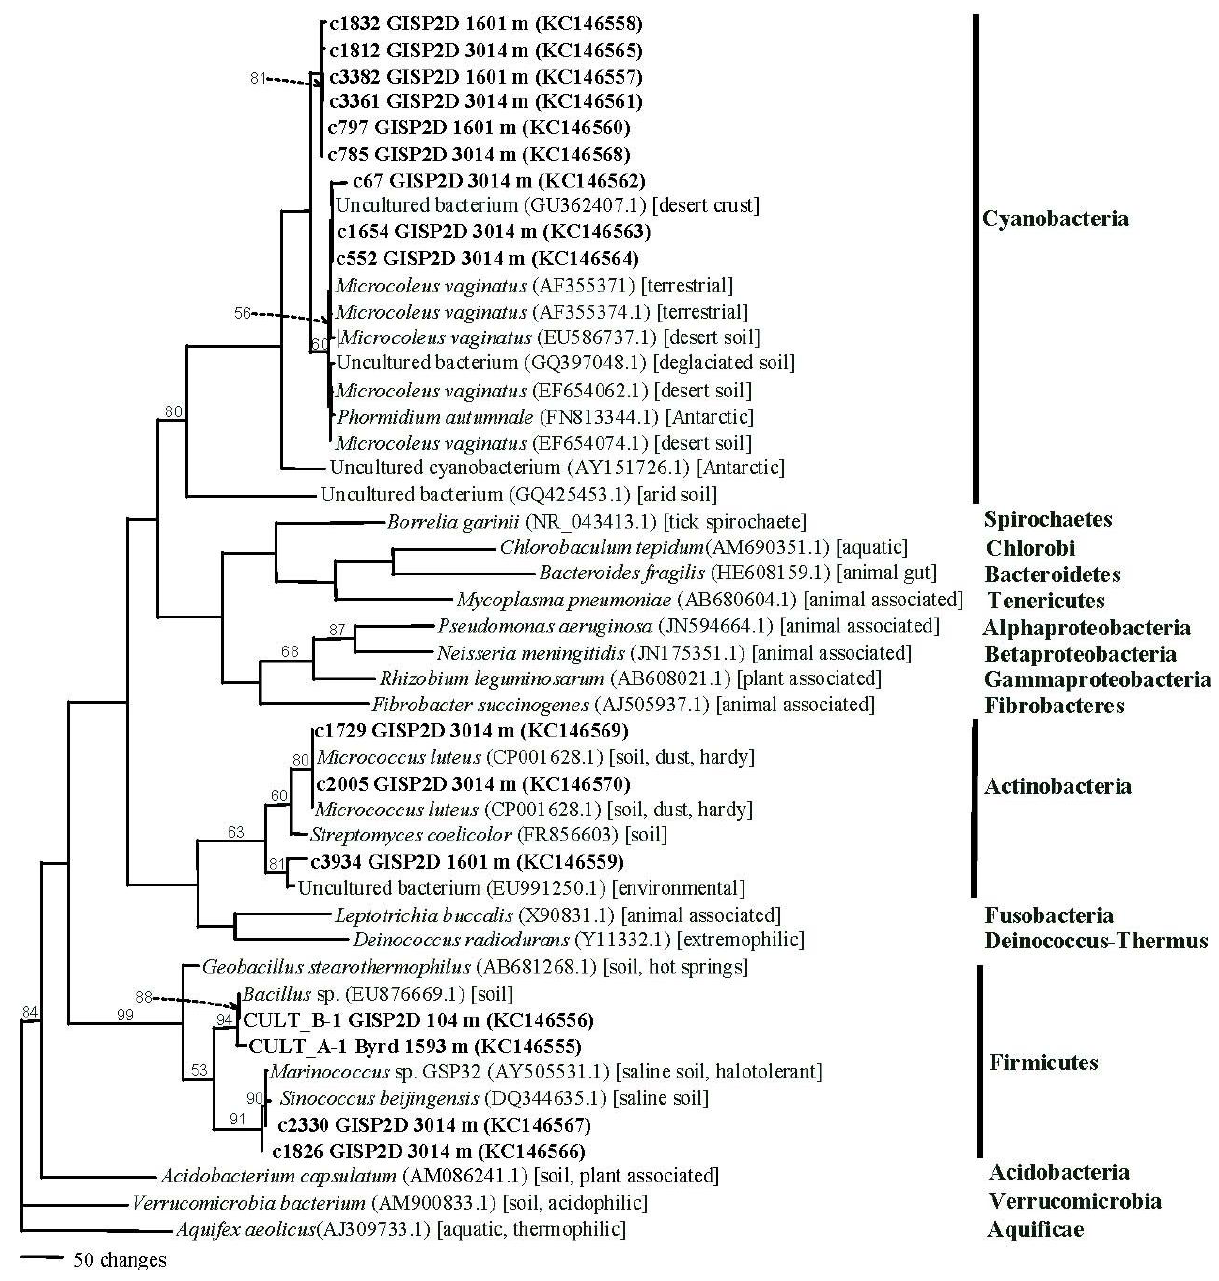
Figure 6. Phylogram of bacterial small subunit ribosomal RNA (SSU rRNA) sequences (maximum parsimony using phylogenetic analysis using parsimony (PAUP) [30]) from the GISP2D and Byrd ice cores. Sequences determined in this study are indicated in bold font. Sequences that start with CULT are isolates. All other sequences in bold were from the metagenomic/metatranscriptomic analysis. Ice core location and depth (meters below the glacial surface) are indicated. Phyla are on the right. The closest National Center for Biotechnology Information (NCBI) sequences to the queried sequences were selected from BLAST search results for use in the phylogenetic analysis. NCBI accession numbers (in parentheses) and sources of isolates (square brackets) are provided. Bootstrap values (1,000 replications) are given for branches with support greater than